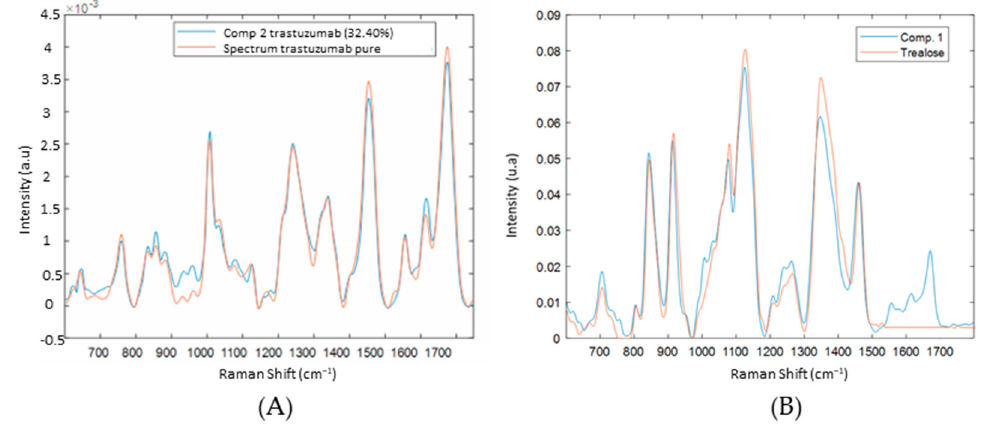
Figure 8. ( A ) Superimposition of the Raman spectrum, acquired at the outer edge of the drop with the spectrum of the protein purified with the Microbiospin ® . ( B ) Superimposition of the Raman spectrum, acquired at the center edge of the drop with the spectrum of the excipient (trehalose).